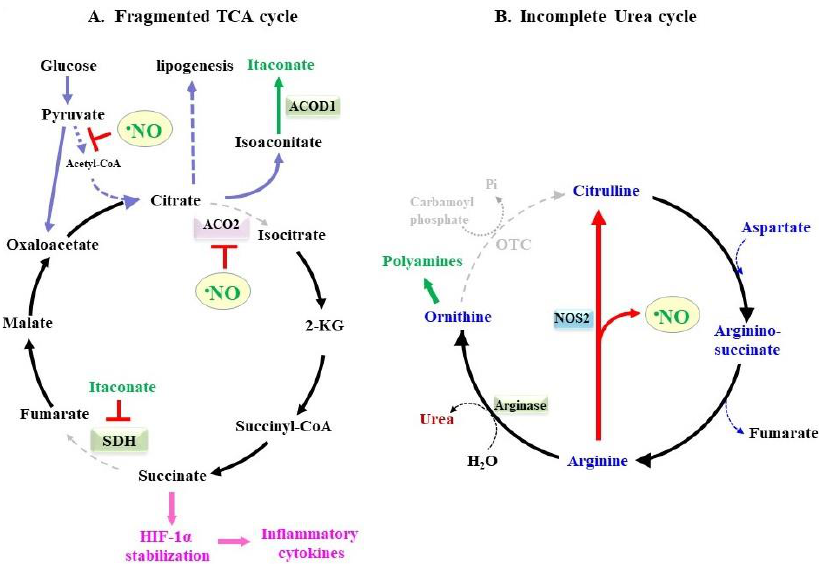
Figure 4. Metabolic remodeling of TCA cycle and urea cycle. ( A ) The TCA cycle in M1 macrophages is fragmented in the reaction catalyzed by ACO2, which leads to the flow of carbon to lipogenesis and the production of itaconate by means of ACOD1. ROS and RNOS are involved in the suppression of ACO2. The resulting itaconate inhibits SDH, which leads to the activation of HIF-1 α and the subsequent induction of genes for inflammatory cytokines and glycolysis. ( B ) • NO is produced from arginine by NOS2 and results in citrulline. Since macrophages do not express OTC, ornithine is not utilized for citrulline synthesis, but is recruited for the synthesis of